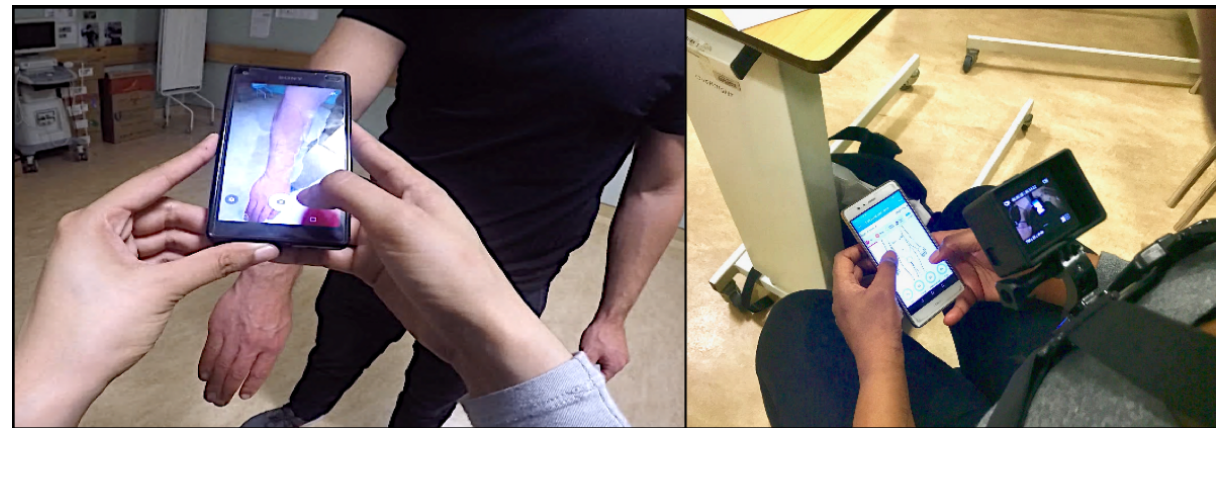
Table 3. Usability themes and